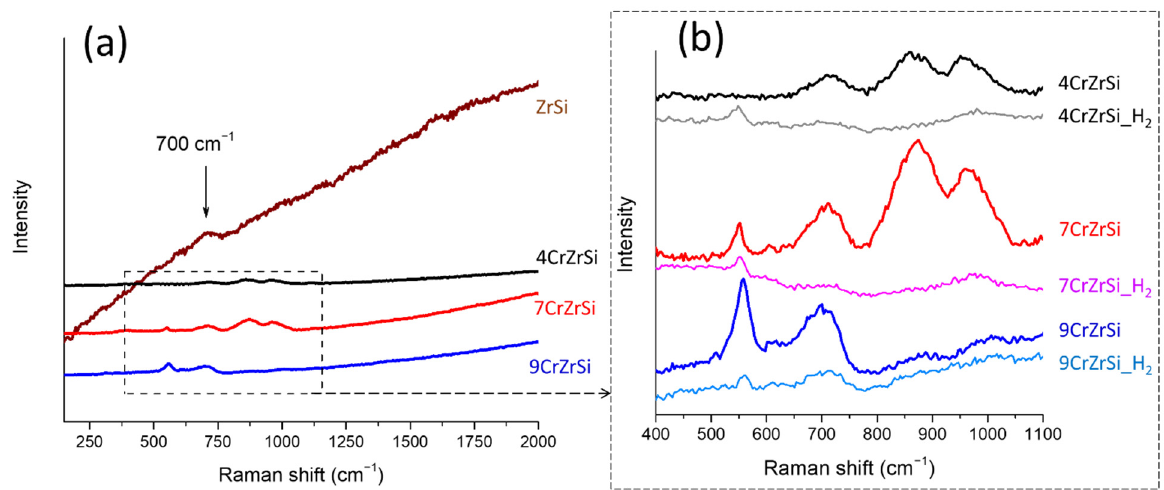
Figure 4. Raman spectra of fresh ZrSi and CrZrSi catalysts ( a ) and the 400–1100 cm − 1 region of Raman spectra of fresh and H 2 -reduced CrZrSi catalysts ( b ).